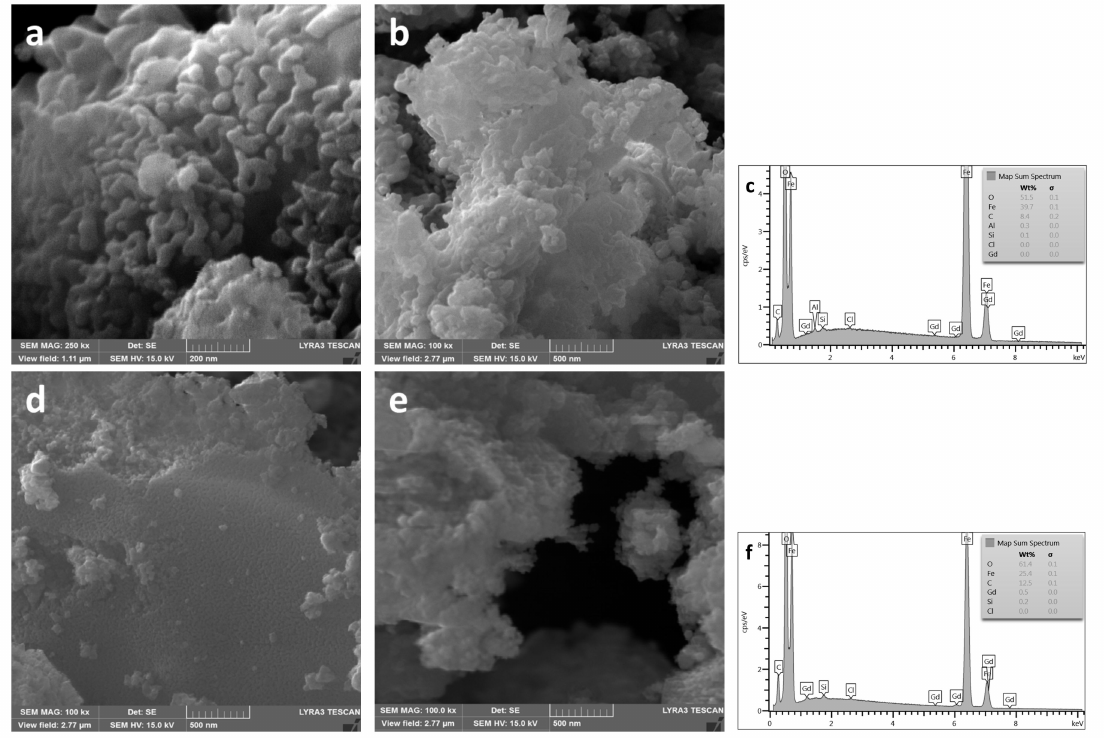
Figure 7. SEM images and EDX spectrum of powders produced at 550 ◦ C: ( a – c )—S4 (undoped Fe 2 O 3 ); ( d – f )—S5 (0.5 mol % Gd-doped Fe 2 O 3